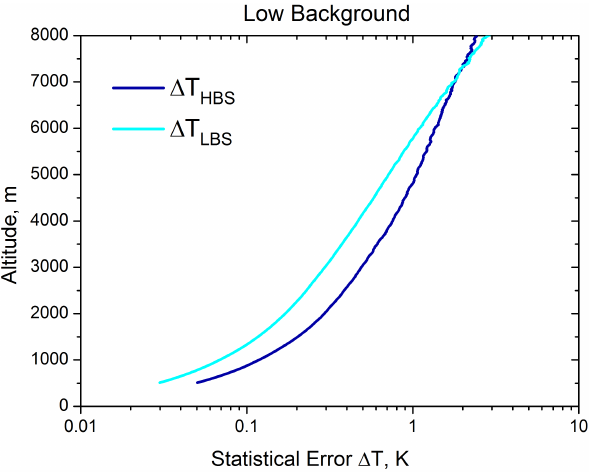
Figure 12. Ratio of high-background-setting uncertainties (cid:49)T HBS to low-background-setting uncertainties (cid:49)T LBS . A ratio above 1 shows better performance for the low-background setting compared to the high-background setting. In cases with no background, this advantage is clearly significant at lower altitudes but decreases with height. On the other hand, the high-background setting is superior already above 1km in high-background conditions. But it should be noted that the altitude where the high-background setting becomes preferable depends on the signal-to-background